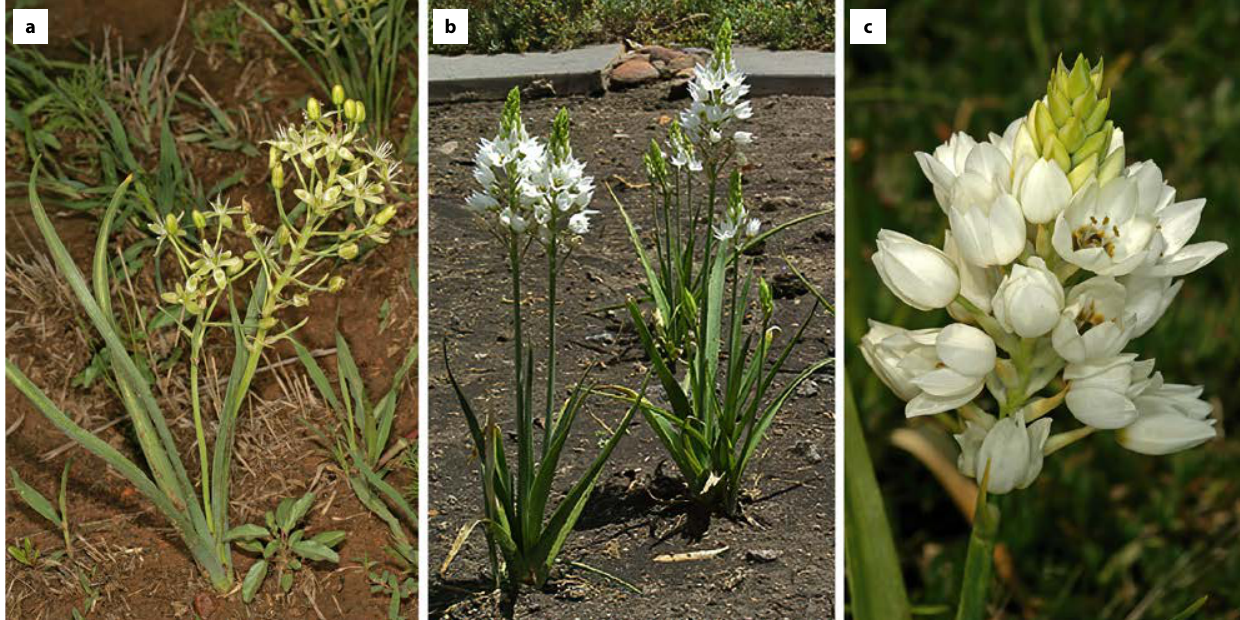
Figure 5: (a) Albuca prasina (= Ornithogalum prasinum ) or bushveld chincherinchee, and (b & c) Ornithogalum thyrsoides (Star-of-Bethlehem) Photographs: A.E. van Wyk (a, c) & C.J. Botha (b)